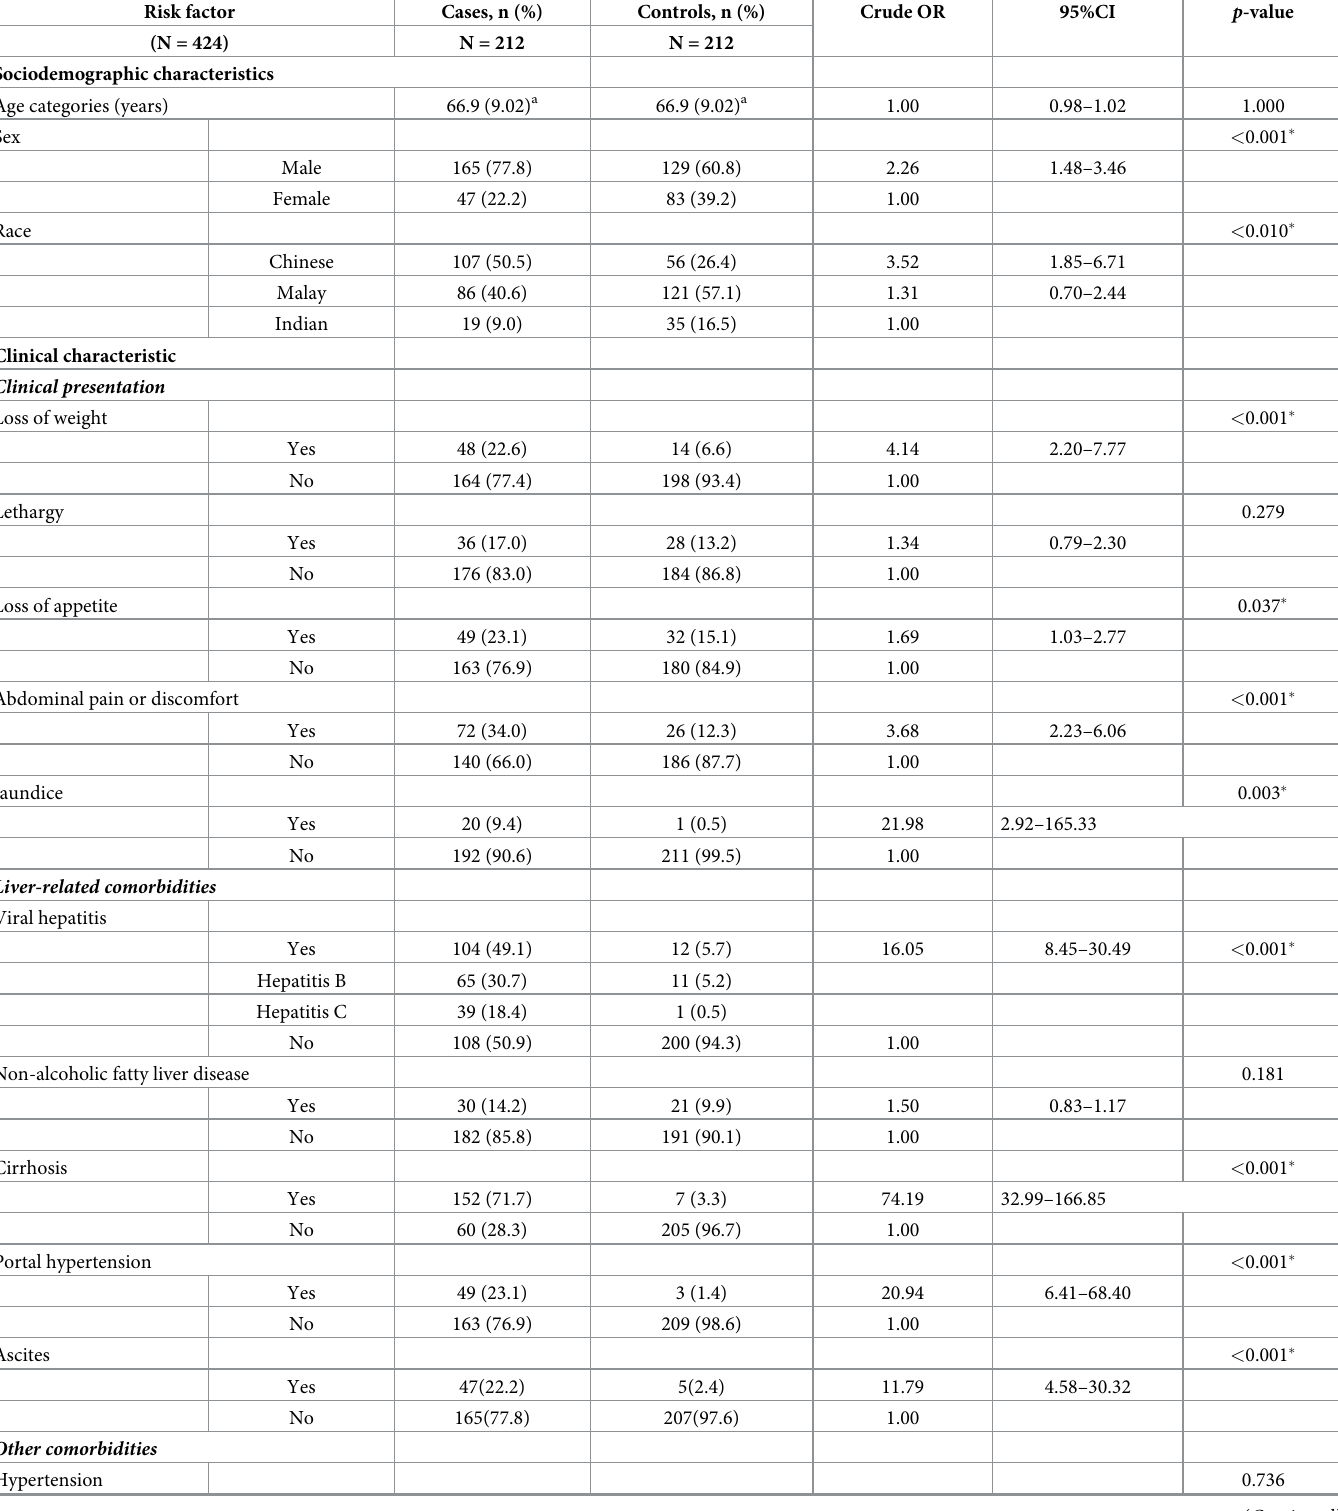
Table 1. Univariate logistic regression analysis of risk factors for HCC among T2DM